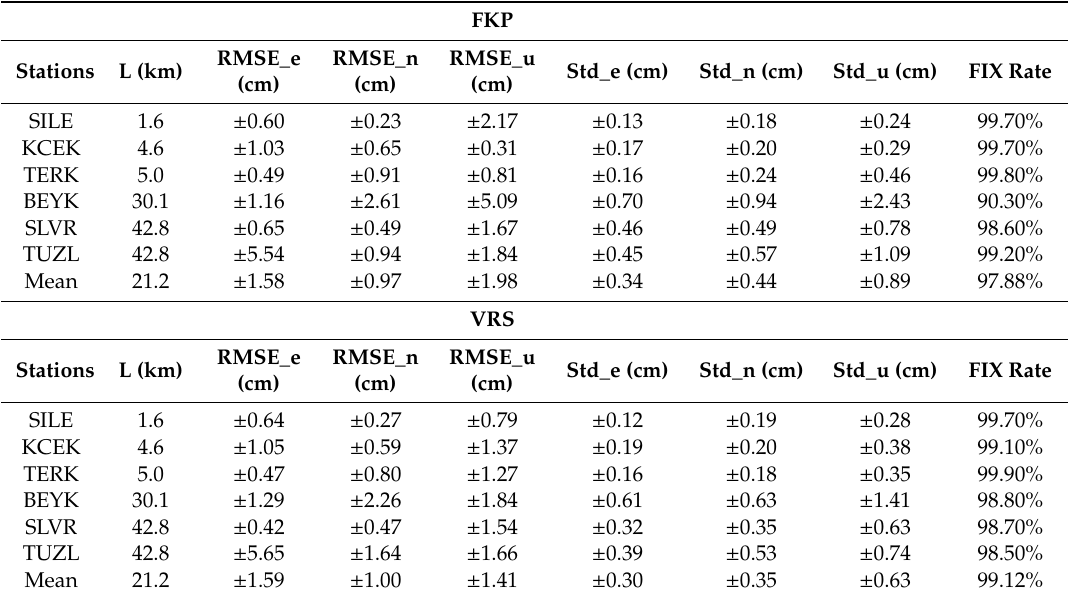
Table 2. RMSE and standard deviation values for the six test points.